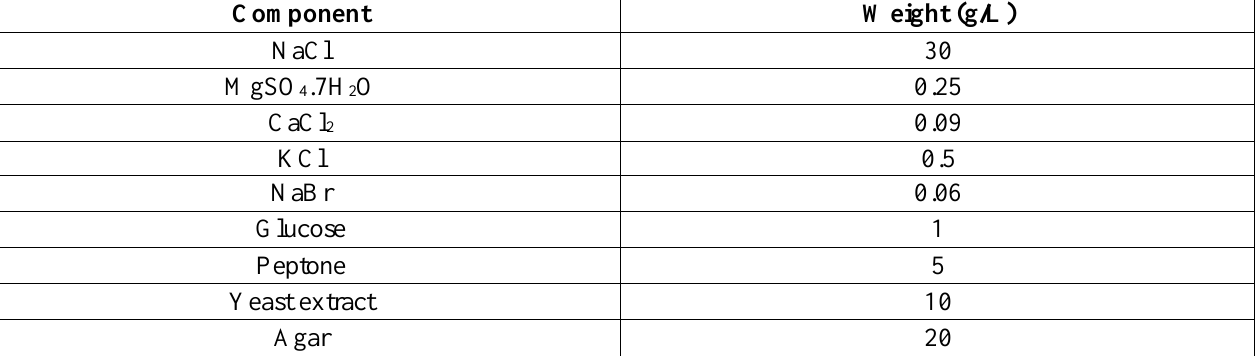
Table 2: PHA production medium